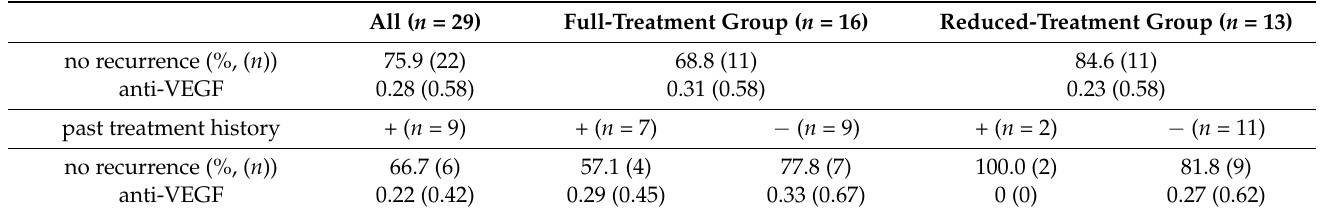
Table 2. No-recurrence rate and the total number of additional treatments during the 1-year follow-up. All ( n = 29)